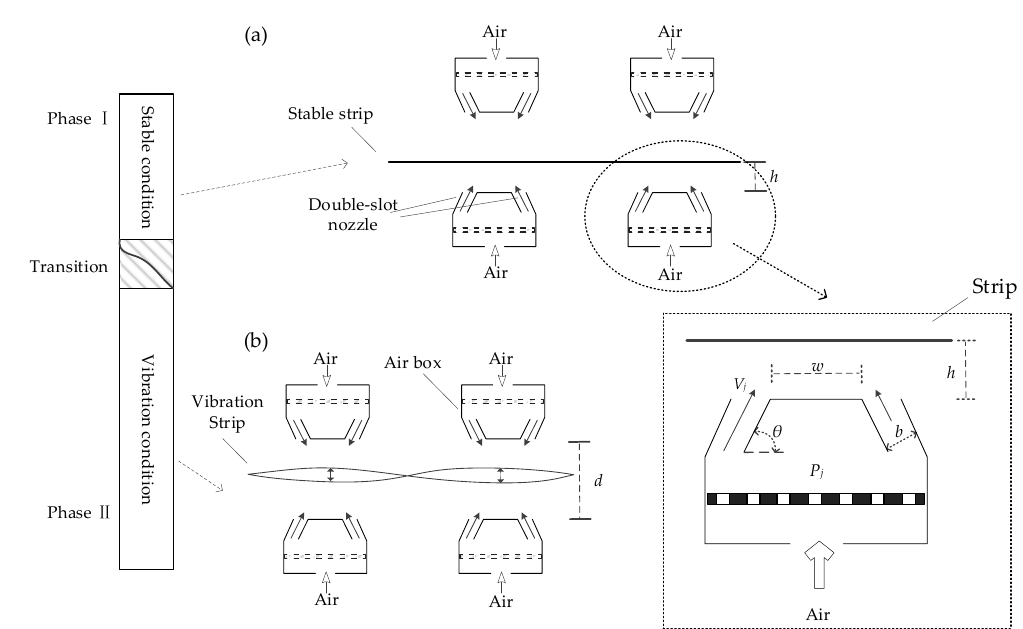
Figure 1. Schematic diagram of the floating process: ( a ) diagram of the stable state and ( b ) diagram of the vibration state.